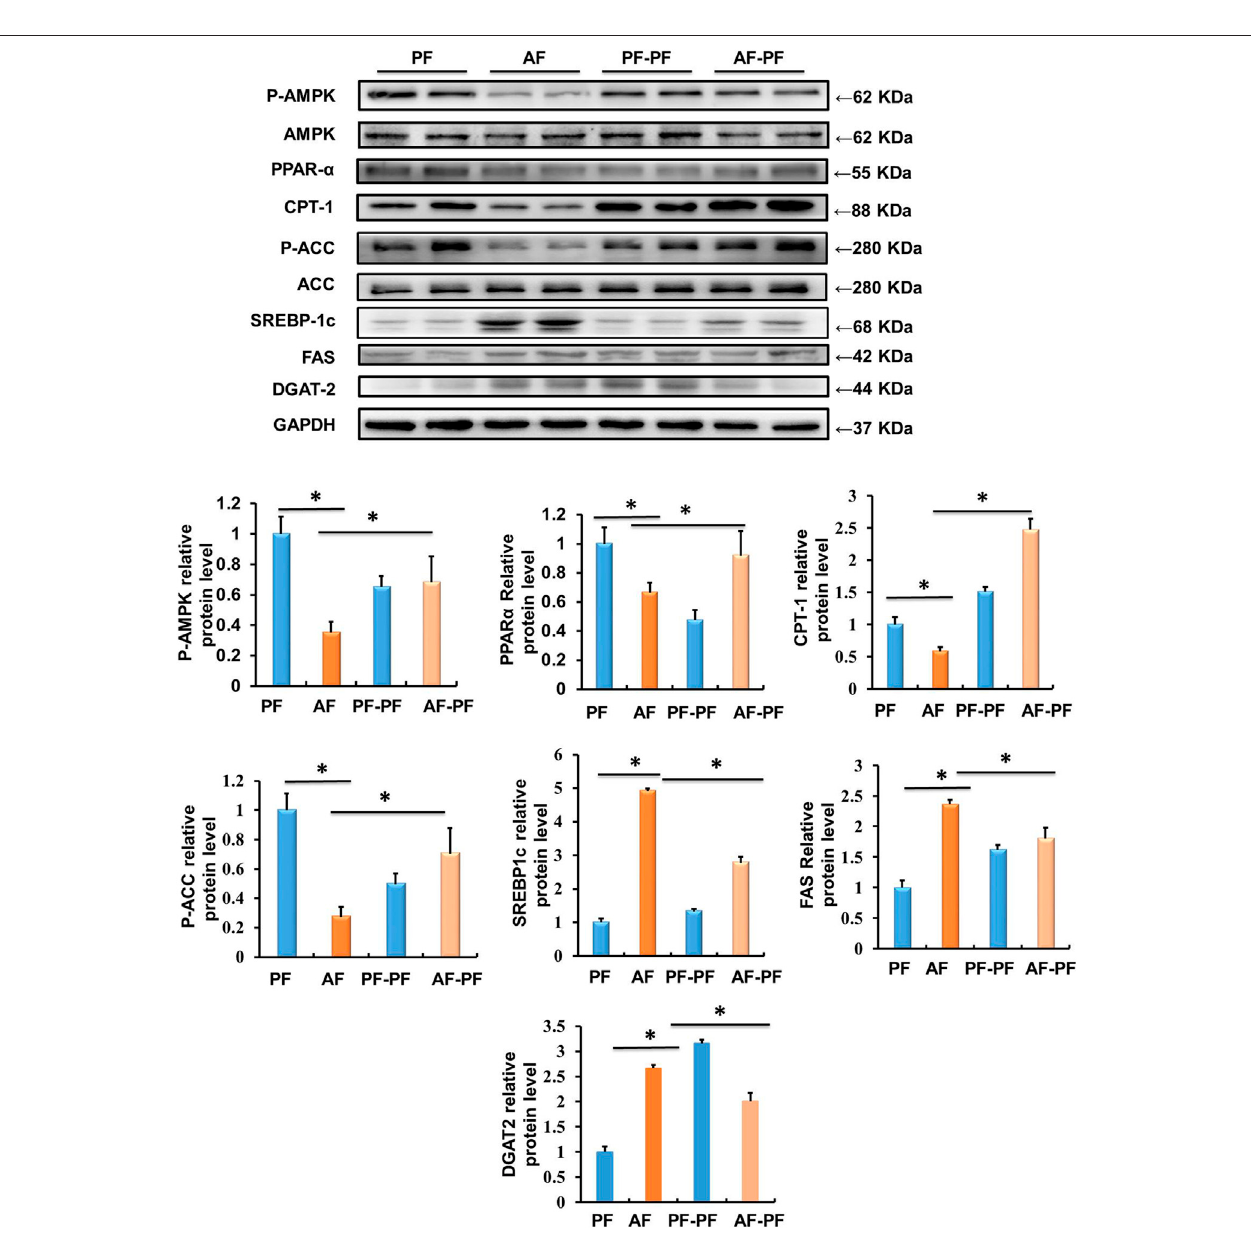
FIGURE 3 | Alcohol withdrawal improves proteins related to liver lipid metabolism. Total cellular lysates were extracted from the liver samples. Western blot was performed to detect the expressions of p-AMPK, PPAR- α , CPT-1, p-ACC, mature-SREBP-1c, FAS, and DGAT-2. * p < 0.05 indicates statistically signi fi cant differences ( n (cid:1)